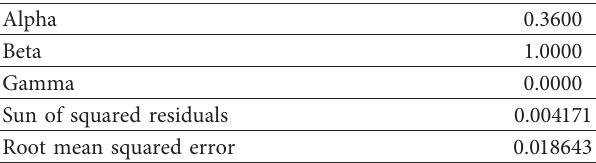
Table 4: The prediction and fitting data of the Grey Verhulst model.